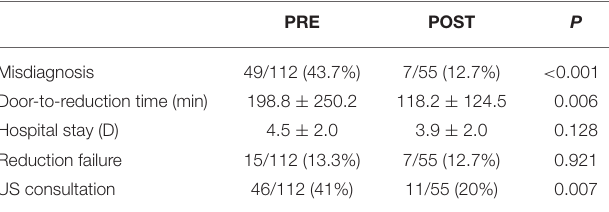
TABLE 2 | Comparison of misdiagnosis and outcome between the PRE and POST group. PRE POST P